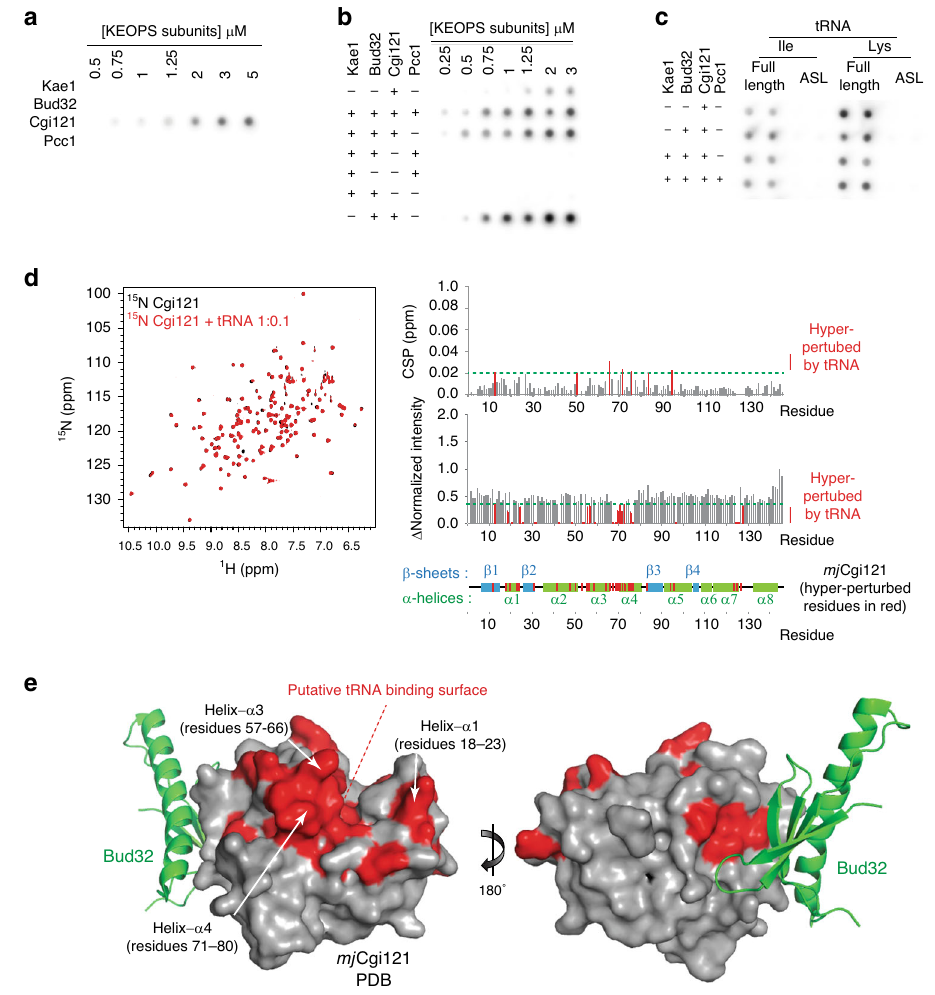
Fig. 1 mj Cgi121 is the tRNA-binding subunit of ar KEOPS. a , b Binding activity of ar KEOPS, individual subunits, and subcomplexes towards mj tRNA Lys assessed using a fi lter binding assay. Protein concentrations and the speci fi c ar KEOPS proteins tested are indicated. c Binding activity of ar KEOPS mj Cgi121- containing complexes at 1 µ M concentration towards full length mj tRNA Lys , sc tRNA Ile , or their respective anticodon stem loops (ASL) assessed using the fi lter binding assay. d (Left) Nuclear magnetic resonance 1 H- 15 N-HSQC analysis of 15 N-labeled mj Cgi121 in the presence or absence of 1:0.1 molar ratio of mj tRNA Lys . (Right) Chemical shift perturbations (CSPs) and the peak intensity changes of assigned resonances are shown. Residues with CSP ≥ 0.02 ppm (top graph) or peak intensity changes of ≤ 0.4 (bottom graph) were considered hyper-perturbed by the tRNA. Thresholds are highlighted on graphs by horizontal dashed green lines. Hyper-perturbed residues and their projections on a schematic representation of the secondary structure of mj Cgi121 (bottom) are highlighted in red. e Projection of hyper-perturbed residues from ( d ) in red on the surface structure of mj Cgi121 (PDB 3ENH) identi fi es a putative tRNA-binding surface. Bud32 (green ribbon) was shown previously to bind to a site remote from the identi fi ed tRNA-binding surface. For clarity, only mj Cgi121 and part of mj Bud32 are shown (residues 344-419 of the naturally occurring mj 1130 Kae1-Bud32 fusion